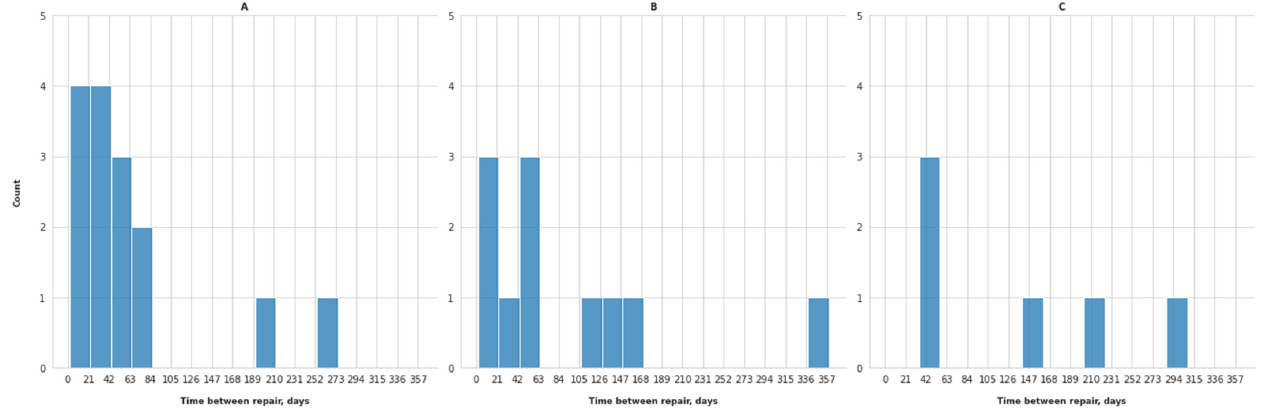
Figure 11. Histograms of time between repairs of ( A ), ( B ), and ( C ) elements in mining unit named III.